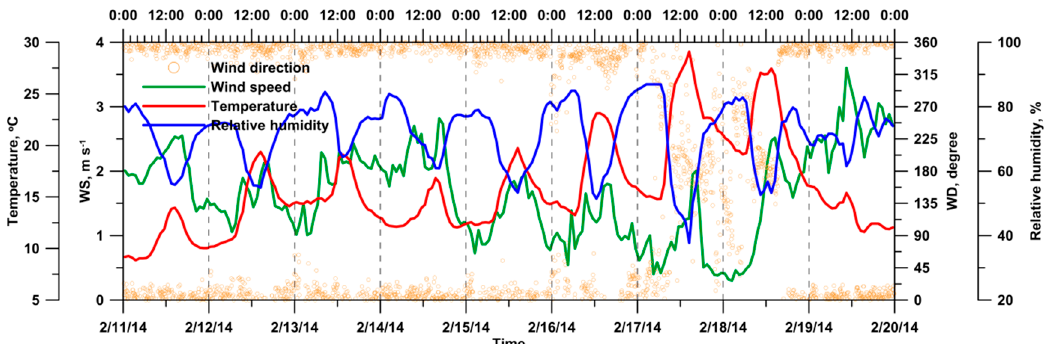
Figure 2. Time variations of meteorological conditions at the monitoring site during the whole monitoring period.